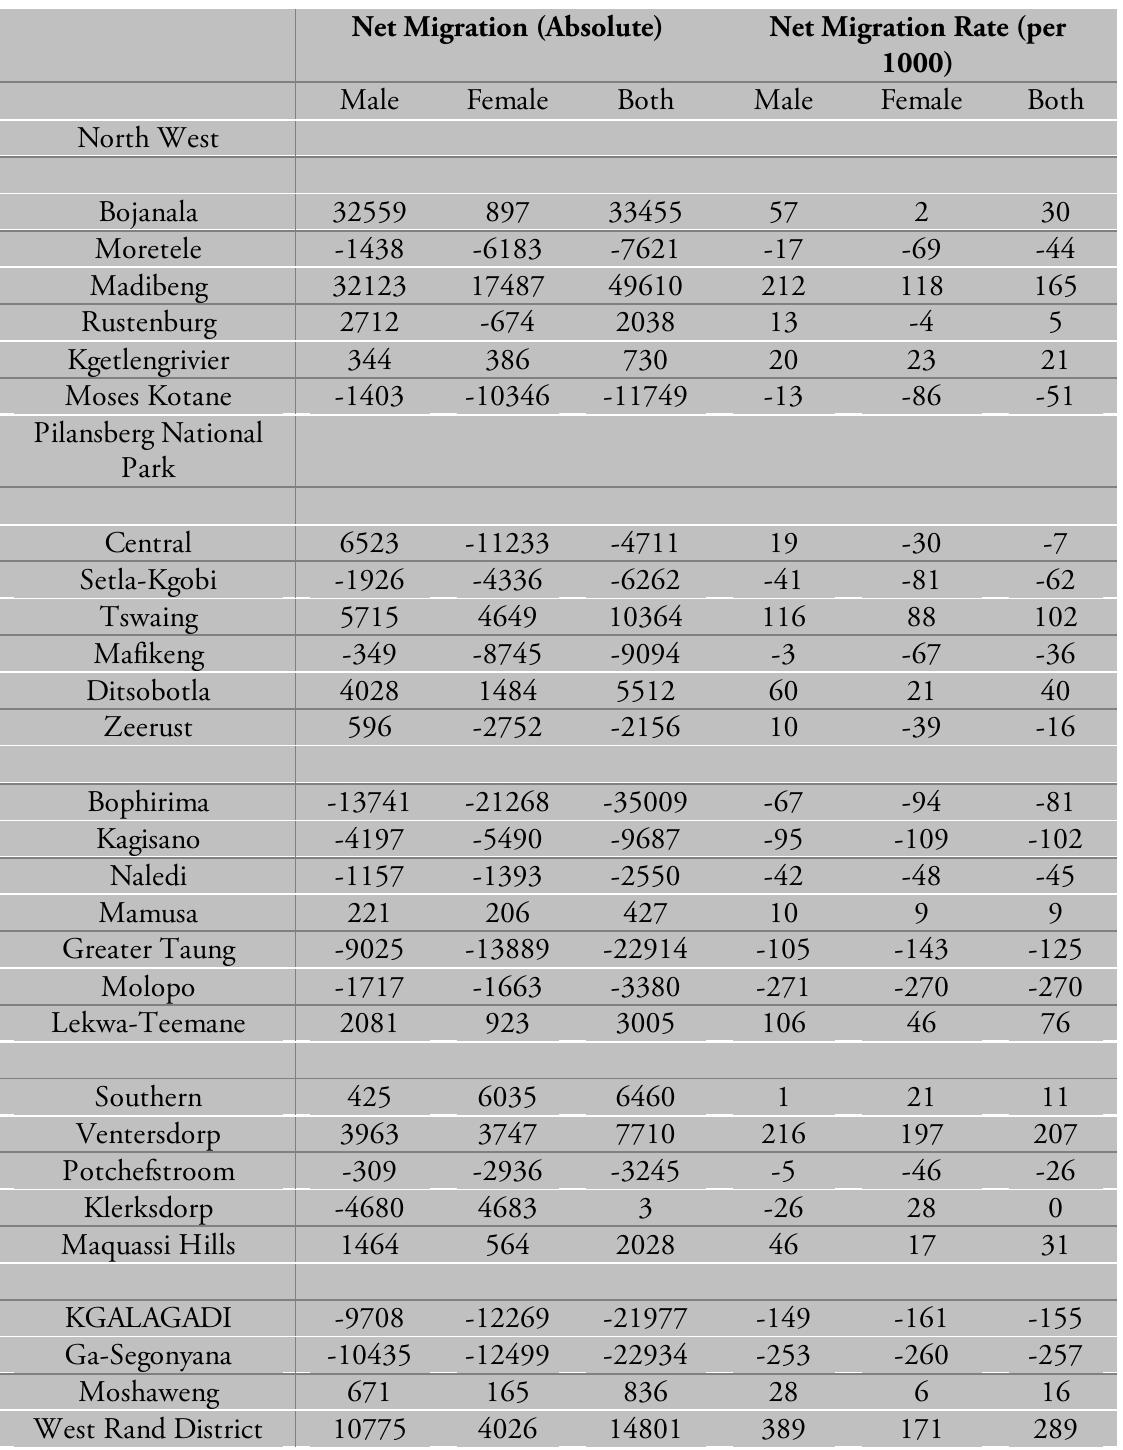
Table 4: Estimates of Net Migration by Regions and District, North West,